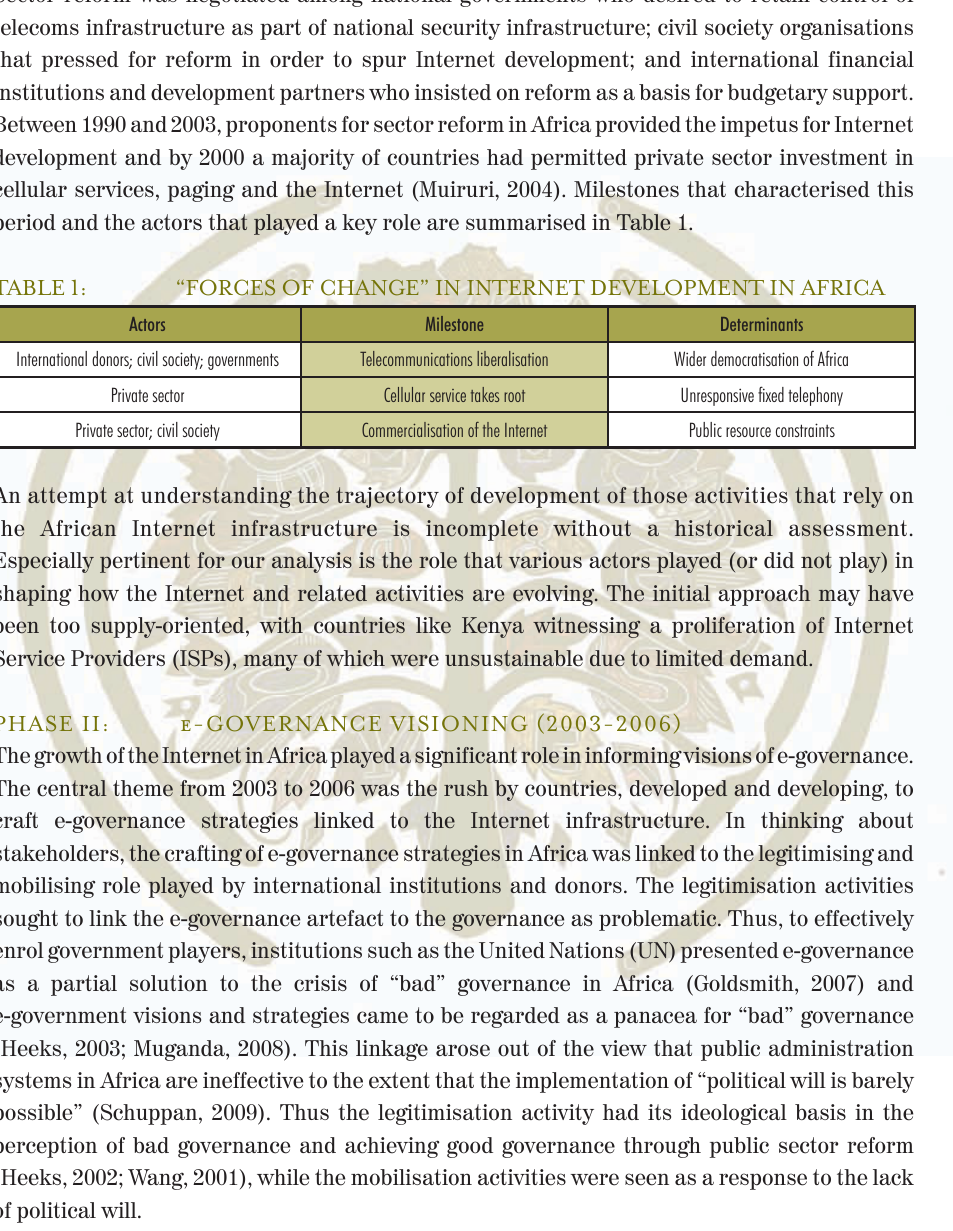
TABLE 1: “FORCES OF CHANGE” IN INTERNET DEVELOPMENT IN AFRICA Actors Milestone Determinants